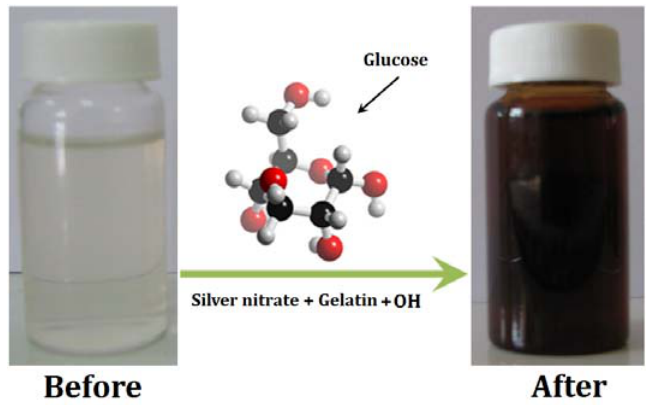
Figure 1. Schematic of the preparation process of